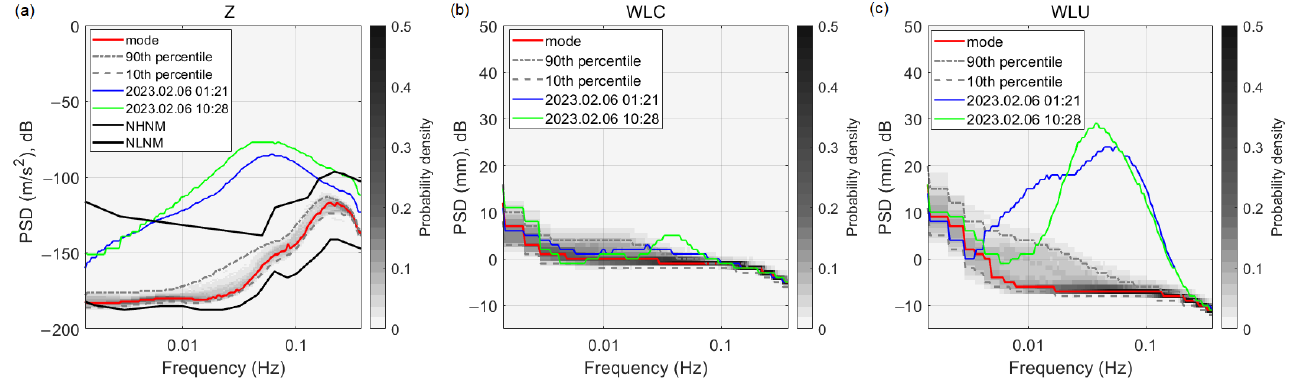
Figure 11. Probability density function of power spectral density: of the ground velocity (OBN station) ( a ), WLC ( b ) and WLU ( c ) aquifers in comparison with PSD for earthquakes that occurred in Turkey on 6 February 2023.